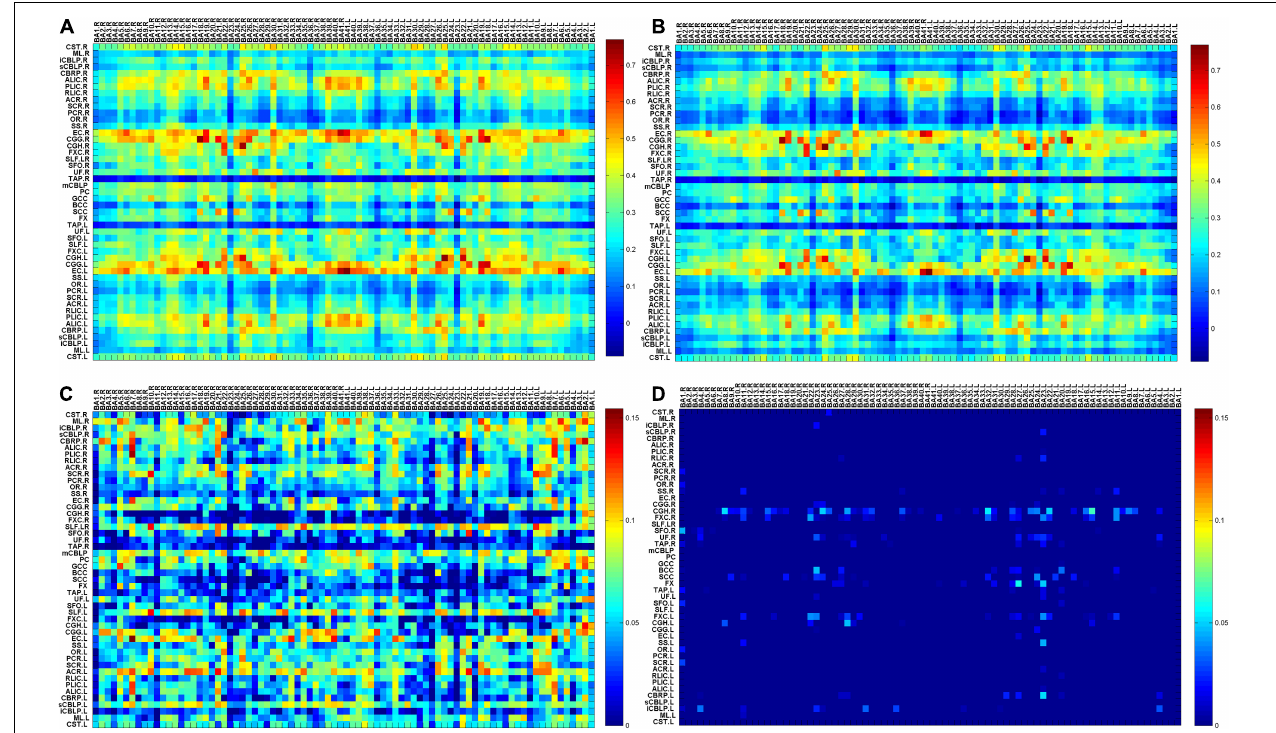
FIGURE 1 | (A) The map of average temporal correlations of the HC group between BOLD signals in 48 WM bundles and 82 GM regions; (B) the map of average temporal correlations of the MWoA group between BOLD signals in 48 WM bundles and 82 GM regions (C) the map of average temporal correlations of the HCs minus those of the patients with MWoA between BOLD signals in 48 WM bundles and 82 GM regions; (D) the map of average temporal correlations of the patients with MWoA minus those of the HCs between BOLD signals in 48 WM bundles and 82 GM regions. Each element is the correlation coefficient (CC) between a pair of WM and GM regions averaged across each group. BA denotes the Brodmann area, and abbreviations for the WM bundles are listed in Supplementary Table 1